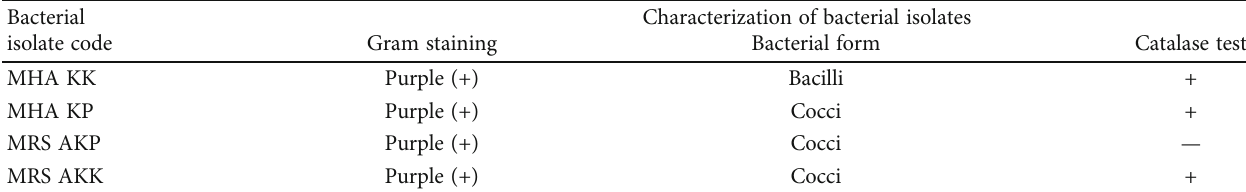
Table 1: Bacterial isolate characterization results from wadi of papuyu.